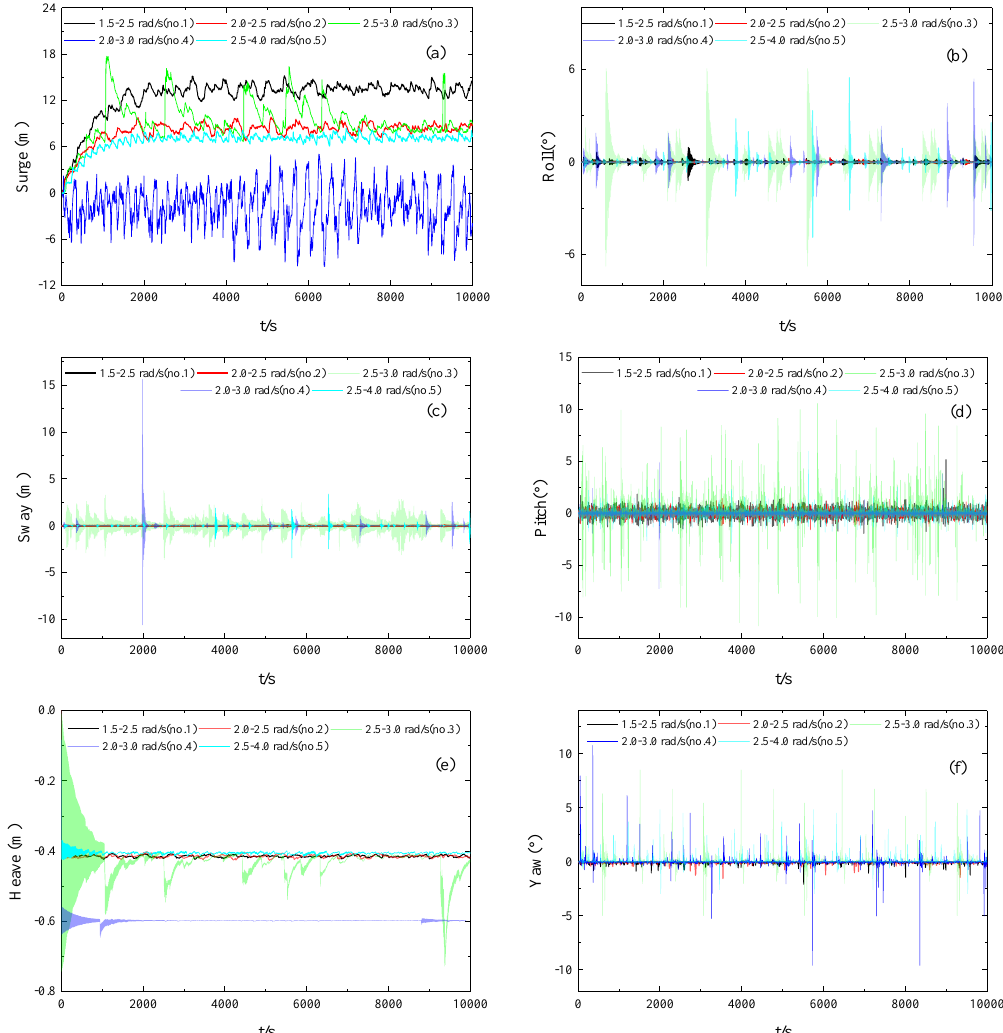
Figure 21. 6DoF time-history motion curves under different start-end frequencies. (Sub-figures: ( a ) surge motion curves; ( b ) roll motion curves; ( c ) sway motion curves; ( d ) pitch motion curves; ( e ) heave motion curves; ( f ) yaw motion curves.). Energies 2020 , 13 , x FOR PEER REVIEW